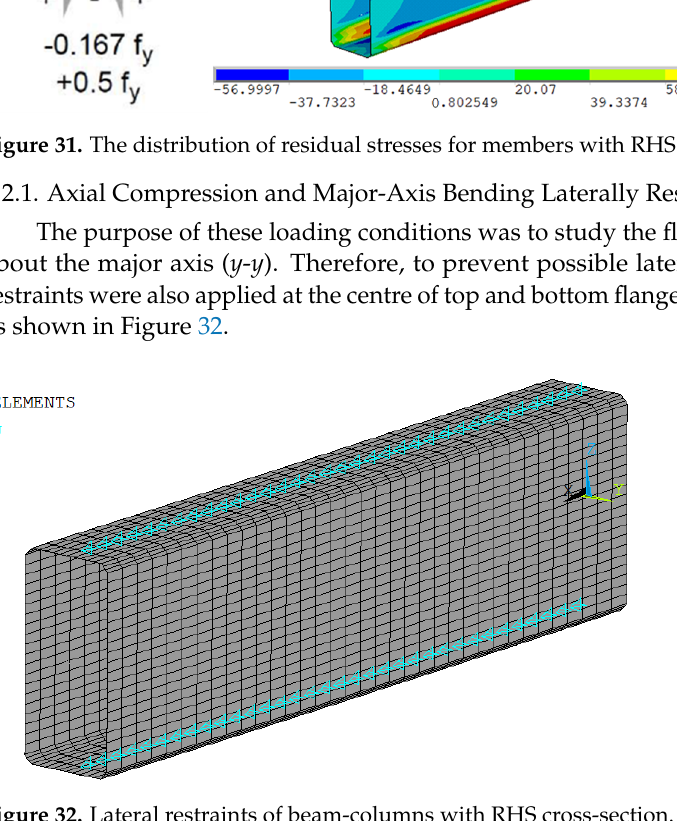
Figure 34. Interaction curves for laterally restrained beam-columns with RHS cross-section. Figure 35. Interaction curves for laterally restrained beam-columns with RHS cross-section.